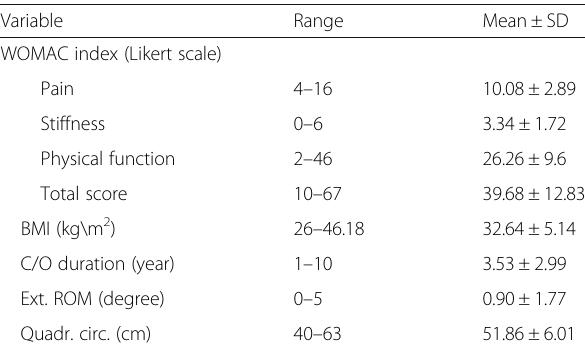
Table 2 WOMAC index subclasses and clinical examination